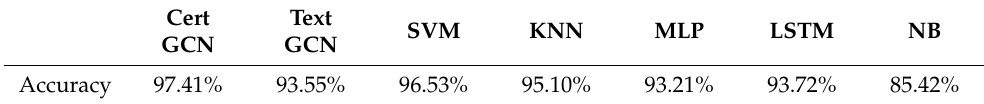
Table 5. Accuracy of different models for malicious certificate detection.